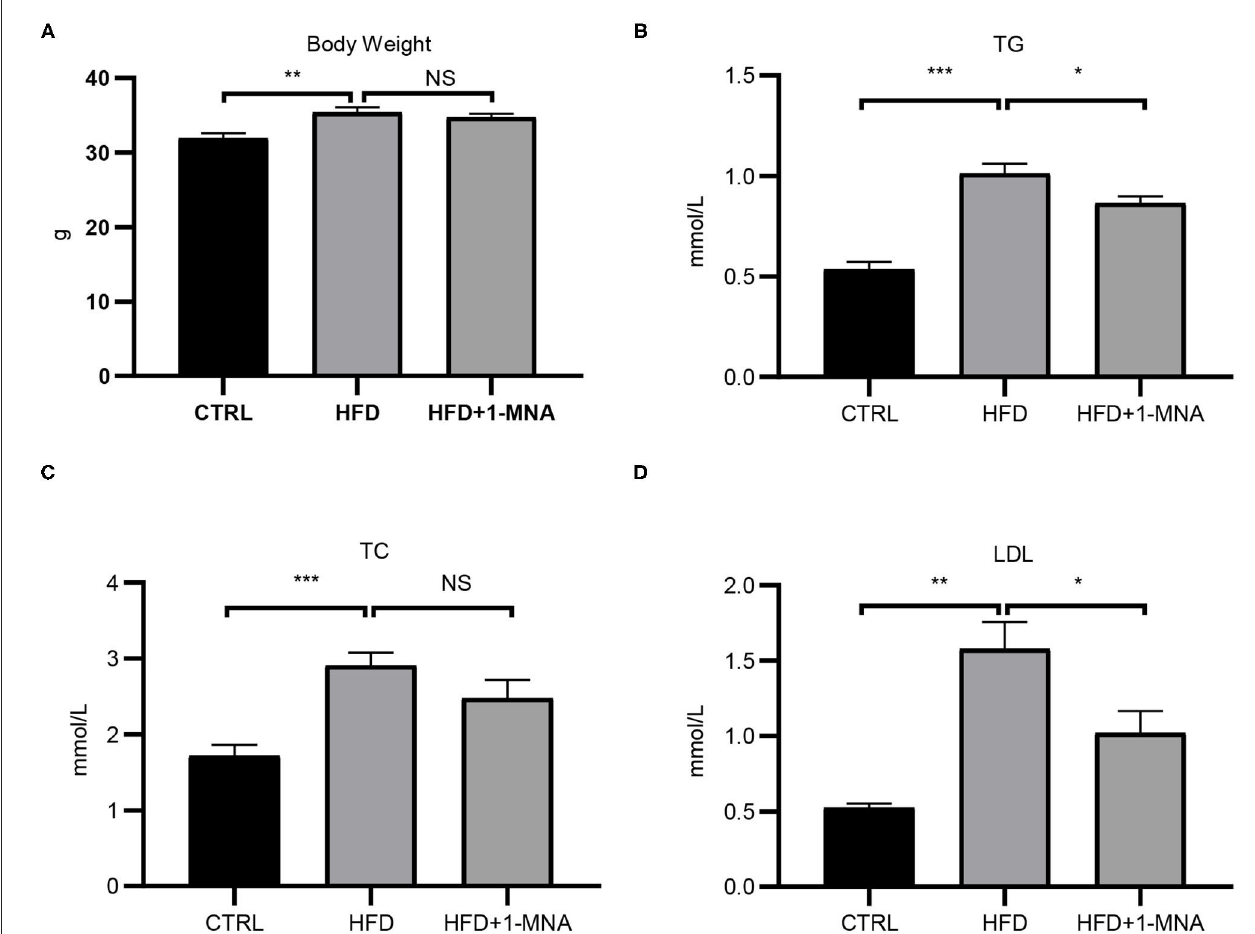
FIGURE 5 | Effects on serum TC, TG, LDL, and body weight following 1-MNA treatment. HFD induces increased (B) serum TG and (D) LDL, which are inhibited by 1-MNA treatment. (A) Body weight and (C) TC were different but not statistically significant. ( n = 3, NS = no significance, * P < 0.05, ** P < 0.01, *** P <